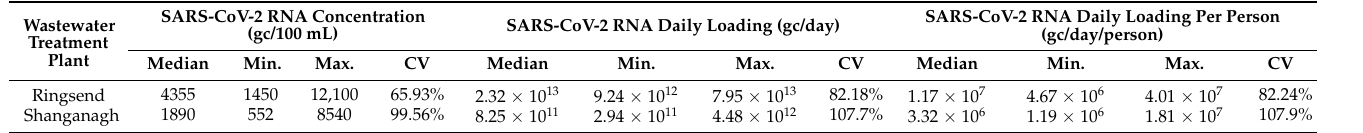
Table 2. The minimum, maximum and median concentrations and daily loadings of SARS-CoV-2 N1 RNA as well as the coefficients of variation (CV) for Ringsend and Shanganagh WWTPs over the sampling period of this